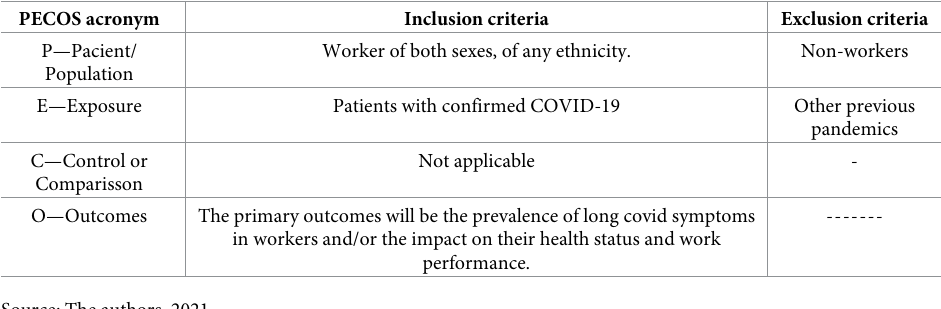
Table 2. Inclusion and exclusion criteria.